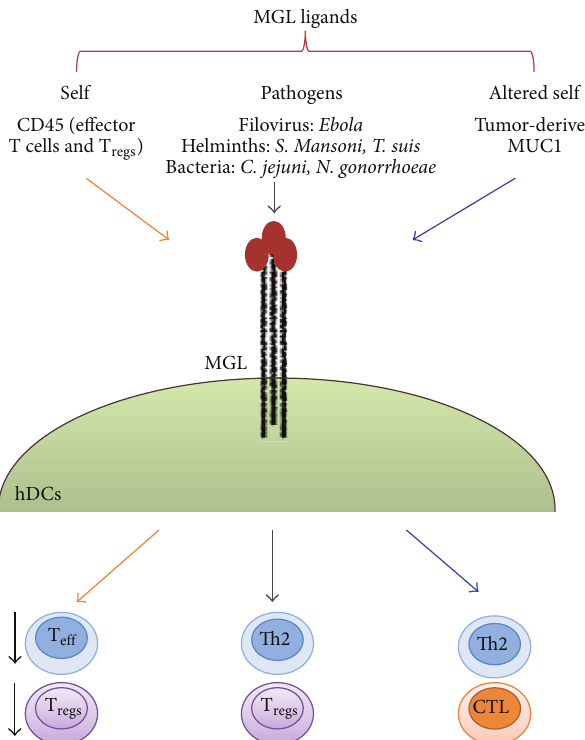
Figure 2: Representation of ligands binding human MGL expressed by DCs and impact of MGL triggering on immune response.